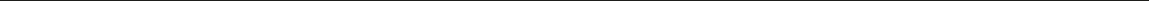
Fig. 3 Mitochondrial components segregate into MVBs and are secreted in exosomes. a Confocal co-localization analysis in HEK293 cells treated with FCCP (4 h) and stained with SSBP1 (red), EEA1 and CD63 (green). Bar, 10 µ m. Graph shows means for Mander ’ s co-localization coef fi cient for SSBP1 and EEA1 or CD63 ( n = 3). t -test: *** P -value < 0.0001. b Confocal co-localization analysis in HEK293 cells co-transfected with Rab7-Q67L-GFP (Rab7mutGFP, green) and mitoDsRed (red), and immunostained for TFAM (purple) and nuclei (HOECHST 58, blue). Center and right images show high magni fi cation of left images (Rab7-Q67L-GFP and mitoDsRed in upper panels; Rab7-Q67L-GFP and TFAM in lower panels). Charts: Fluorescence pro fi les along the corresponding white lines. Bar, 10 µ m. c Mitochondrial components in the exosome fraction obtained from equal numbers of shControl and shnSMase2 J77 T cells. ATAD3, TFAM, and CD63 were detected by immunoblot; mtDNA was detected by PCR for HVRII . Graph: Quanti fi cation of exosomal proteins